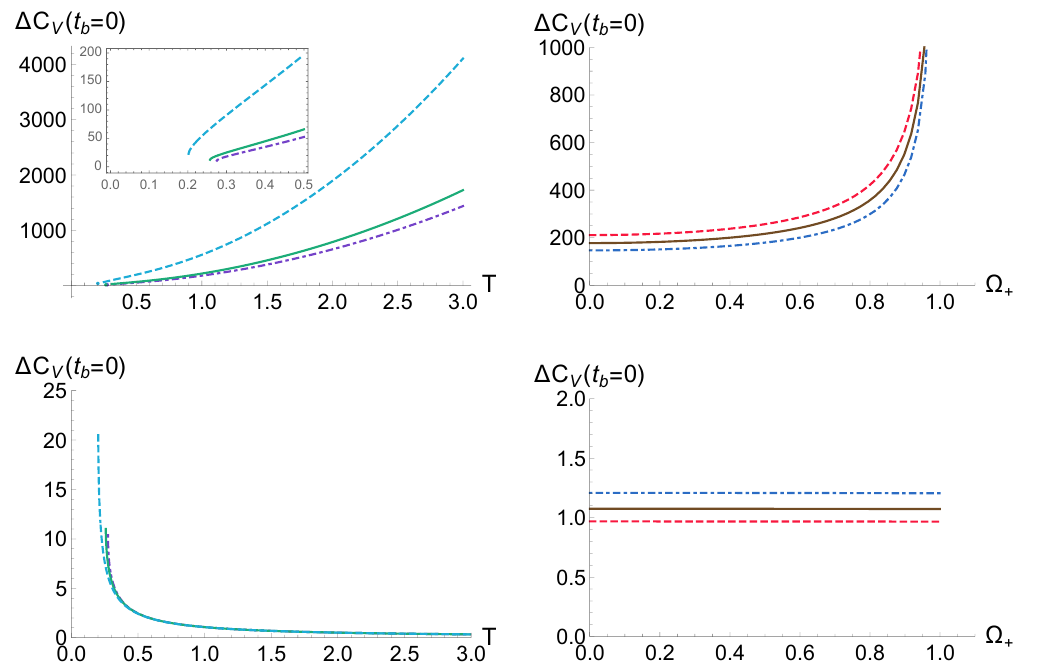
Figure 17 . ∆ C V ( t b = 0) for G N = ‘ = 1 in the grand canonical ensemble for large black holes (upper panels) and small black holes (lower panels). (Left) Temperature dependence for Ω + = 0 . 1 , 0 . 5 , 0 . 9 from the bottom up. (Right) Angular velocity dependence for T = 0 . 9 , 1 , 1 . 1 from the bottom